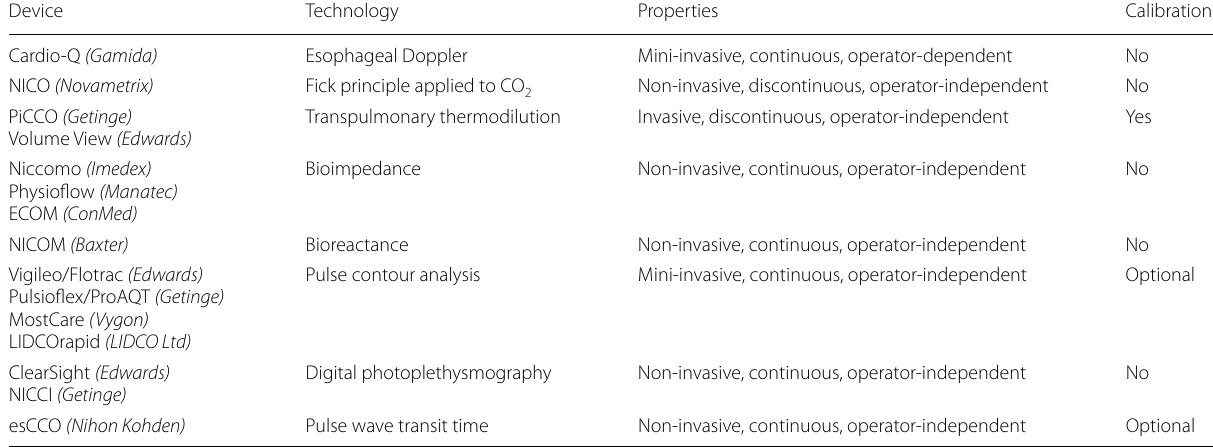
Table 3 Invasive, mini‑invasive, and non‑invasive cardiac output monitoring technologies